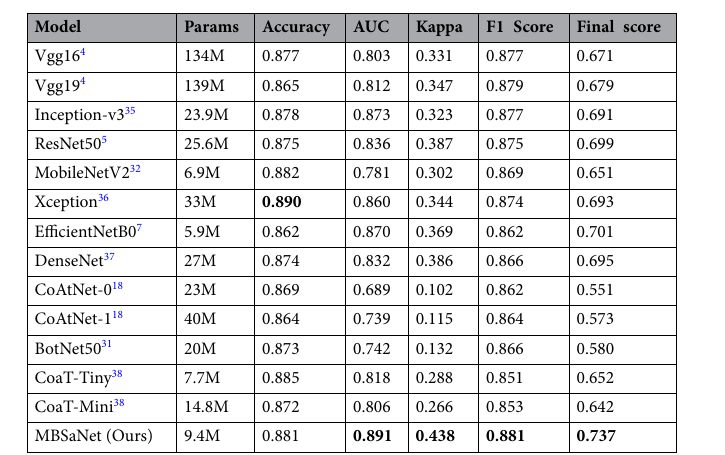
Table 2. Comparison with some CNN networks and hybrid models on the off-site test set. Significant values are in bold.